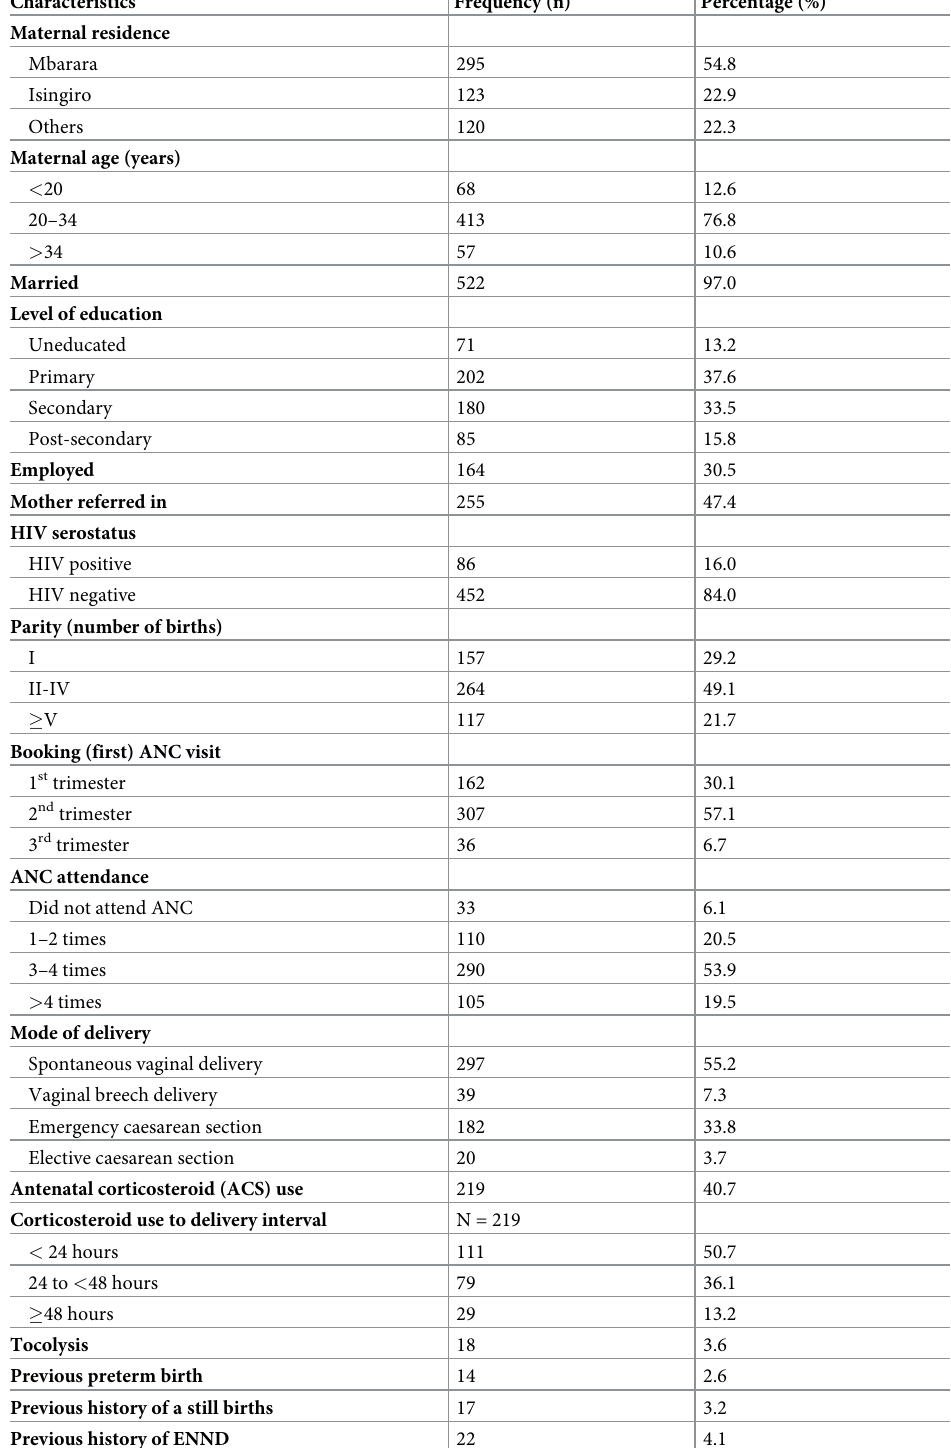
Table 2. Baseline socio-demographic and obstetric characteristics of mothers of preterm neonates born at Mbar- ara Regional Referral Hospital from October 2019 to September 2020 (N =